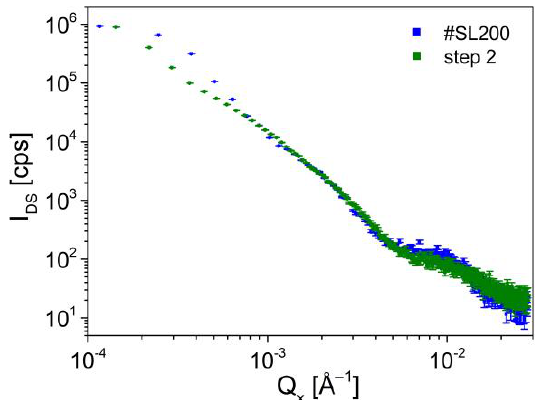
Figure 9. The comparison of log(I DS ) vs. log(Q x ) distributions for #SL200 and step 2 samples.